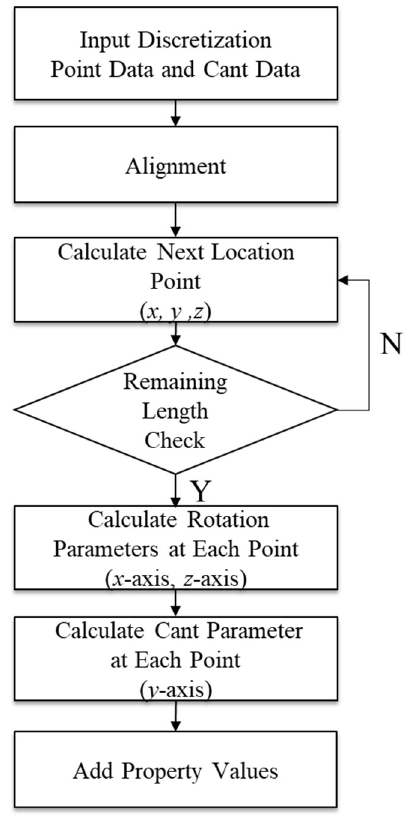
Figure 3. Algorithm for shape representation of discontinuous structures.